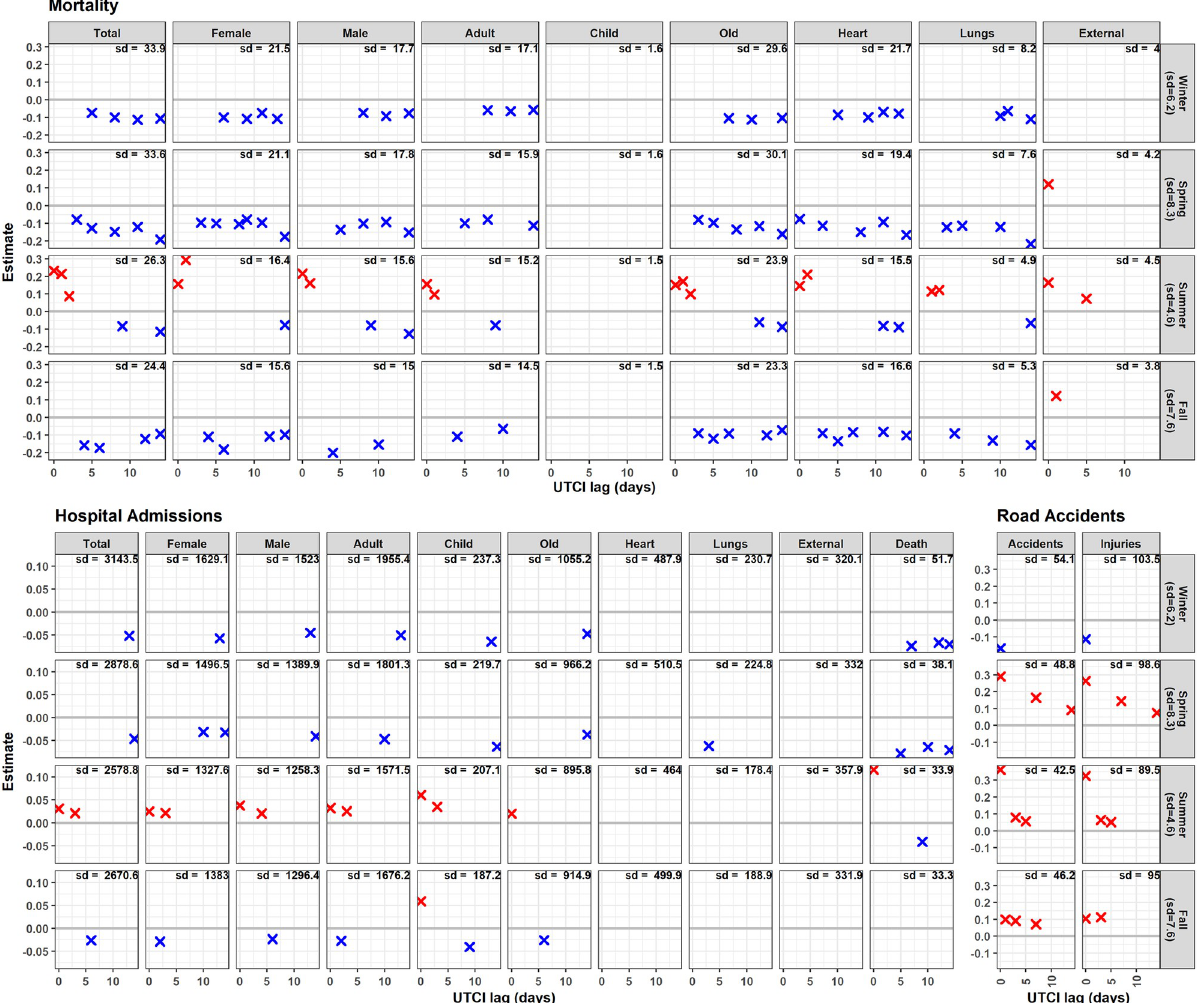
Fig 3. UTCI effects. UTCI effects on daily cases of mortality, hospital admissions, and road accidents for each subgroup and season in Bavaria. The horizontal axis represents the lag in days, and the vertical axis represents the effect estimate, either positive (red) or negative (blue). Crosses are lacking when the effect of UTCI was not significant for a particular lag in the corresponding model. Effect estimates are expressed in proportion of the standard deviation of daily number of cases within the corresponding subgroup (given in the upper right corner of each panel) when UTCI changes by one standard deviation of its daily value for the corresponding season. The numbers in the gray facet titles on the right are the standard deviations of UTCI within each season for the whole of Bavaria. The absence of the crosses indicates that the effect of UTCI was not significant for a particular lag in the corresponding model. Explanatory example: For winter, the UTCI sd is 6.2˚C, the hospital admissions sd is 3143.5, and the estimated UTCI effect is -0.0513. This indicates a decrease in daily hospital admissions in Bavaria by -0.0513 � 3143.5 = 161 when the value of UTCI increases by 6.2˚C.